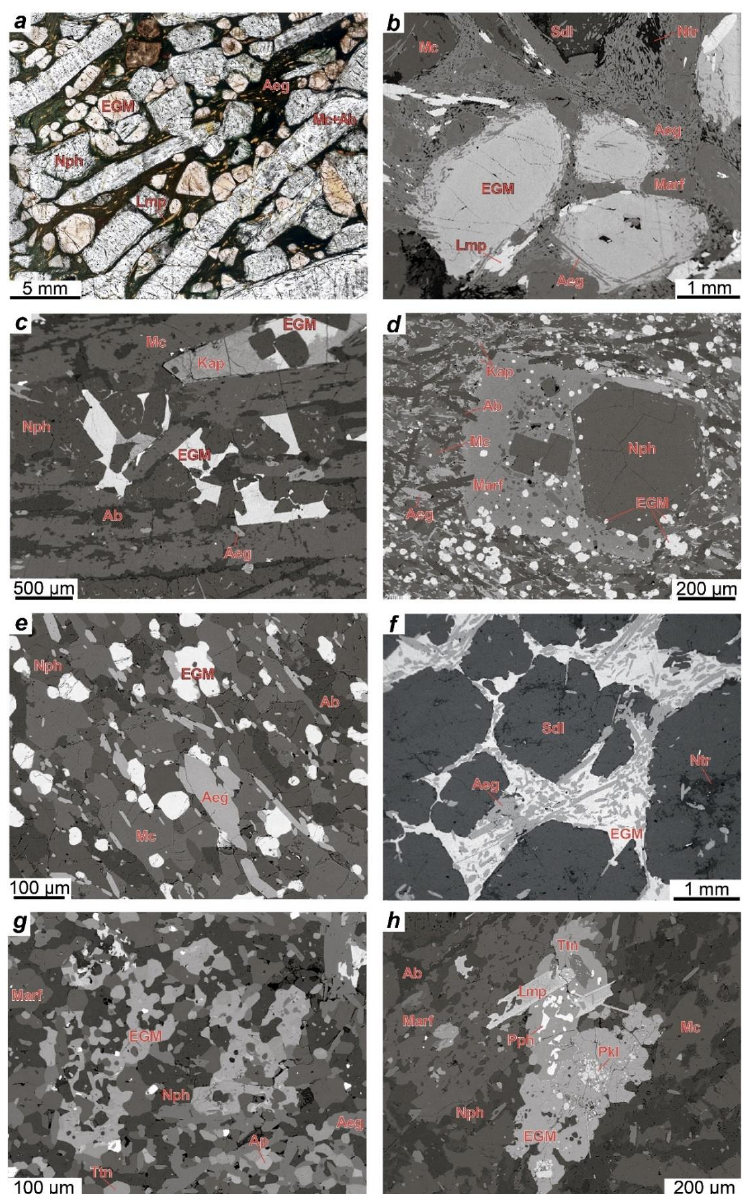
Figure 4. Diversity in morphology of the EGM from the Eudialyte complex of the Lovozero massif. ( a ) Euhedral grains of EGM in eudialyte lujavrite LV-44-6 (Mt. Alluaiv, photo of a polished thin section in transmitted light); BSE-images: ( b ) euhedral grains of EGM in eudialyte lujavrite LV-29-37 (Mt. Alluaiv); ( с ) anhedral grains of EGM in foyaite LV-33-35 (Mt. Alluaiv); ( d ) rounded grains of EGM in porphyritic nepheline syenite LV-191 (Mt. Kuivchorr); ( e ) rounded grains of EGM in fine- grained nepheline syenite LV-154-280 (Mt. Alluaiv). Morphology of other EGM rocks of the Lovozero massif: ( f ) anhedral grains of EGM in sodalite syenite LV-222-448 (Mt. Alluaiv); ( g ) anhedral grains of EGM in metasomatized volcaniclastic rock LV-180b (Mt. Kuivchorr); and ( h ) parakeldyshite surrounded by EGM in metasomatized volcaniclastic rock LV-152-9 (Mt. Appuaiv).